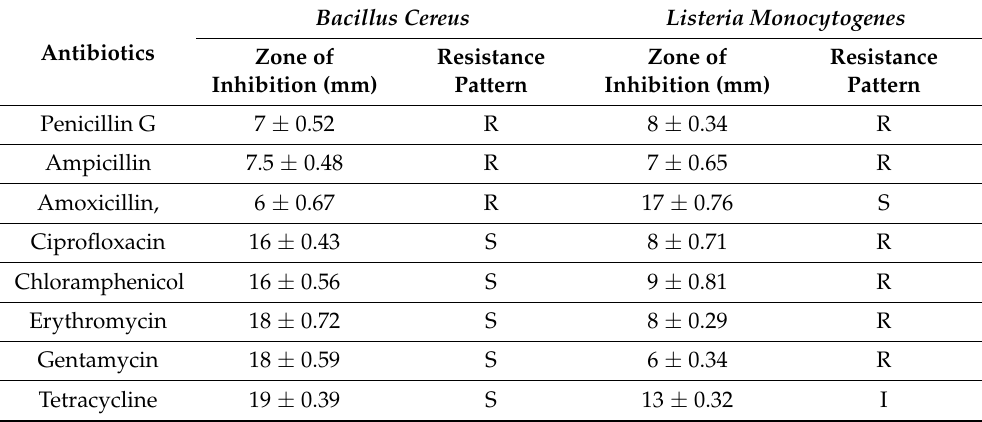
Table 2. The antibiotic sensitivity test for the detection of the resistance pattern of Bacillus cereus and Listeria monocytogenes .